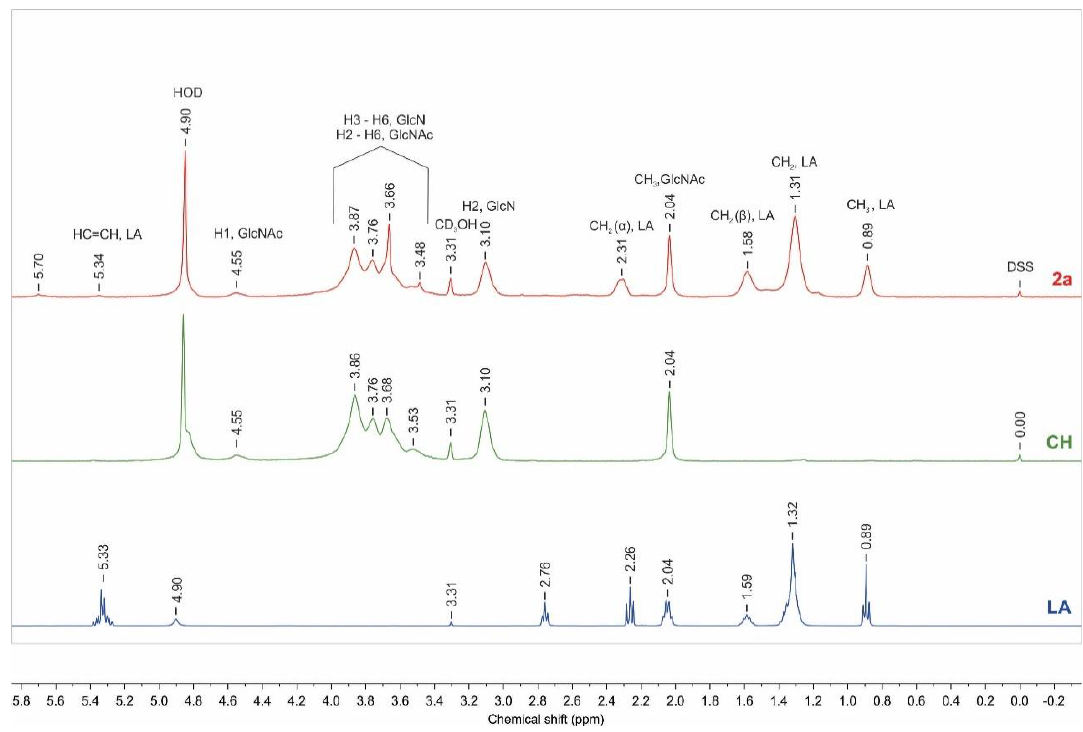
Figure 3. 1 H NMR spectrum of linoleic acid, chitosan and the chitosan derivative 2a.